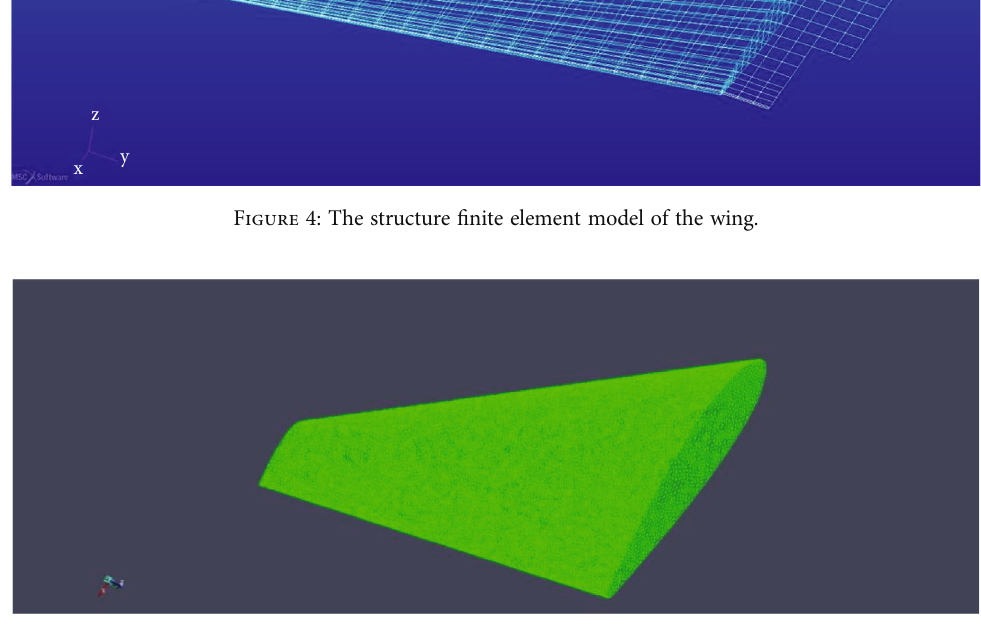
Figure 5: Aerodynamic wall mesh.